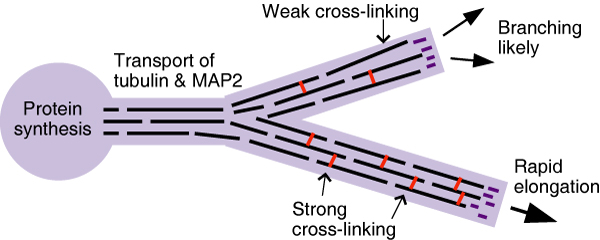
Neurite branching. Construction and stability of the microtubule cytoskeleton may determine both elongation and branching rates. Microtubule bundles are cross-linked by microtubule-associated proteins, such as MAP2. Dephosphorylated MAP2 stabilises the bundles and promotes microtubule assembly, and hence elongation. Phosphorylated MAP2 loses its cross-linking ability, destabilising the bundles and thus increasing the likelihood of neurite branching.